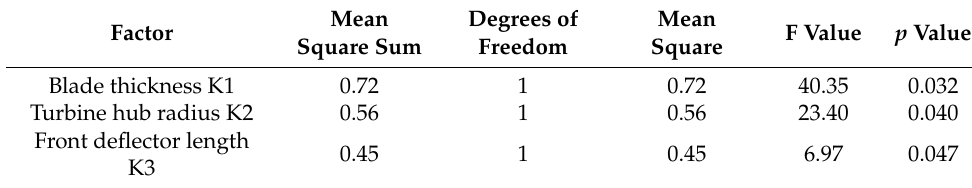
Table 6. Significance table of experimental factors of more significant influencing factors.